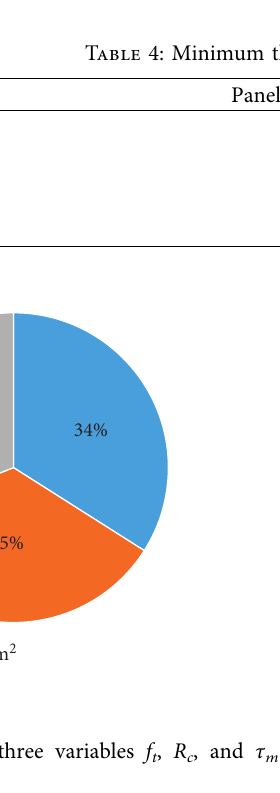
t , R c , and τ m on